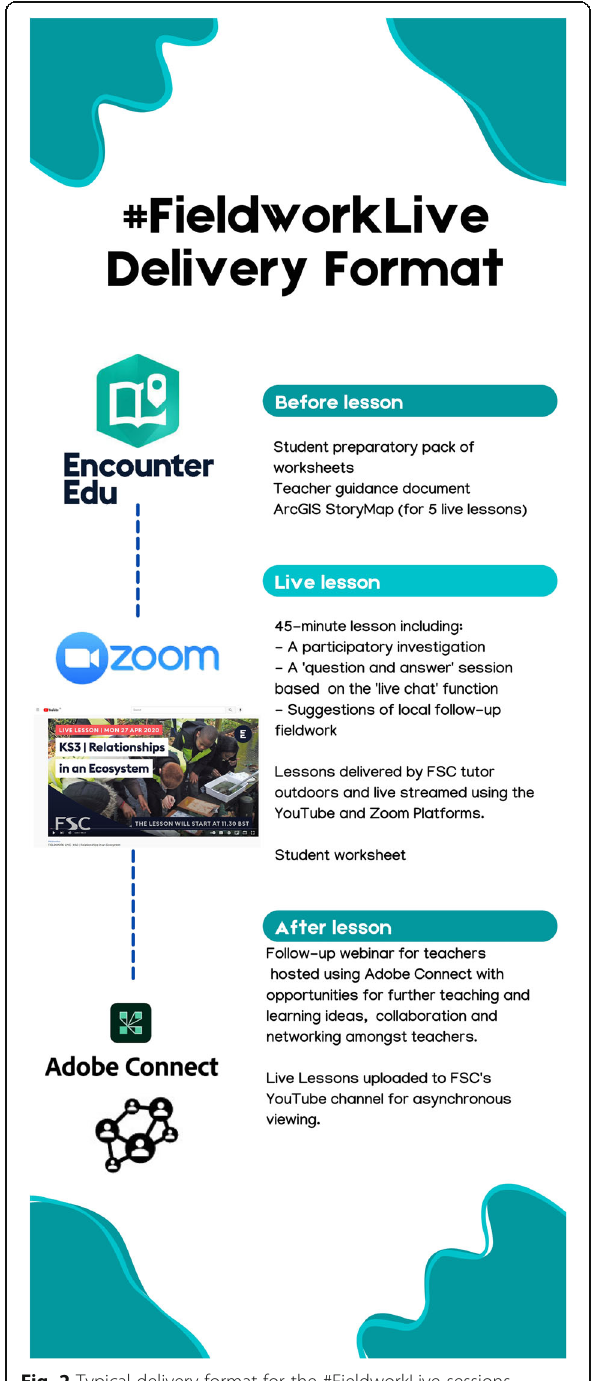
Fig. 2 Typical delivery format for the #FieldworkLive sessions (Live lessons can be viewed by visiting the #FieldworkLive playlist on the FSC YouTube